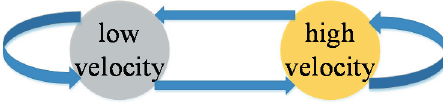
Figure 9. The two models proposed in this paper.